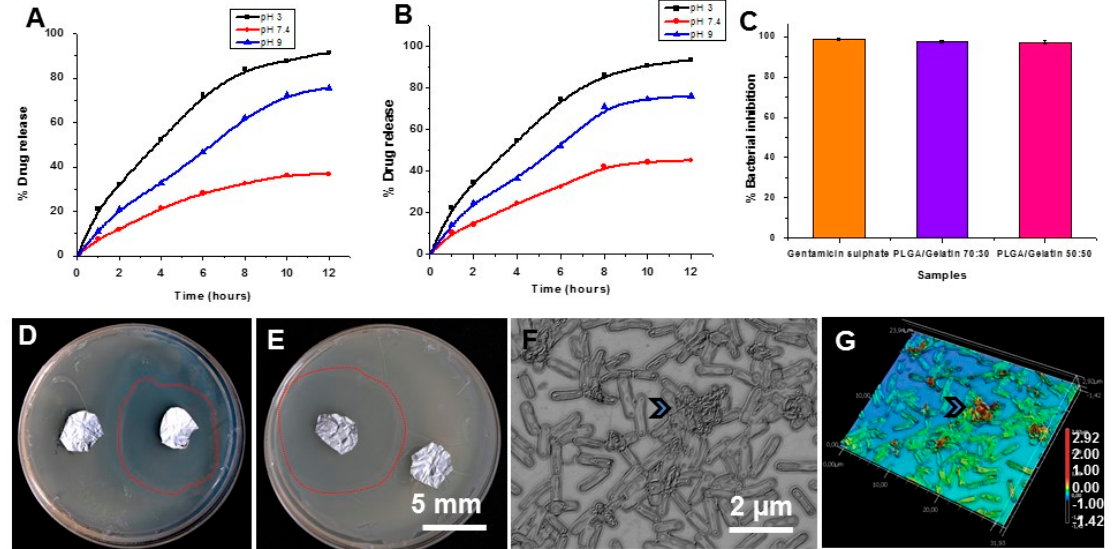
Figure 5. In vitro antibacterial assay. ( A , B ) Release profile of gentamicin sulfate on PLGA/Gelatin 70:30 (A) and 50:50 (B) nanofibrous scaffolds at three different pH values. ( C ) Growth inhibition of Staphylococcus aureus after treatment with PLGA/Gelatin 70:30, PLGA/Gelatin 50:50 nanofibrous scaffolds and Gentamicin sulfate powder in aqueous media. The results are expressed as the median ± standard deviation from five independent experiments performed in triplicate (n = 5). ( D ) Antibacterial activity of gentamicin sulfate loaded PLGA/ Gelatin 70:30 nanofibrous scaffolds against Staphylococcus aureus on LB Agar semisolid media . ( E ) Antibacterial activity of gentamicin sulfate loaded PLGA/Gelatin 50:50 nanofibrous scaffolds against Staphylococcus aureus (dotted red line show zone of inhibitions-ZOI around test sample, next to control). ( F , G ) Optical and laser scanning micrograph from bacterial cells seeded on Gentamicin Sulfate (GS)/PLGA/Gelatin (50:50) surfaces show sunken morphology of bacterial cells trapped in a network of nanofibers scaffolds (arrow heads).